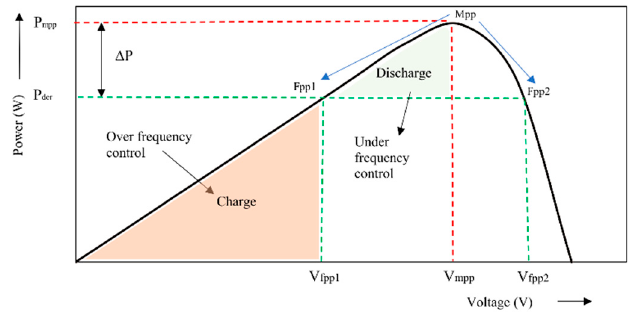
Figure 3. The PV operating point characteristic for